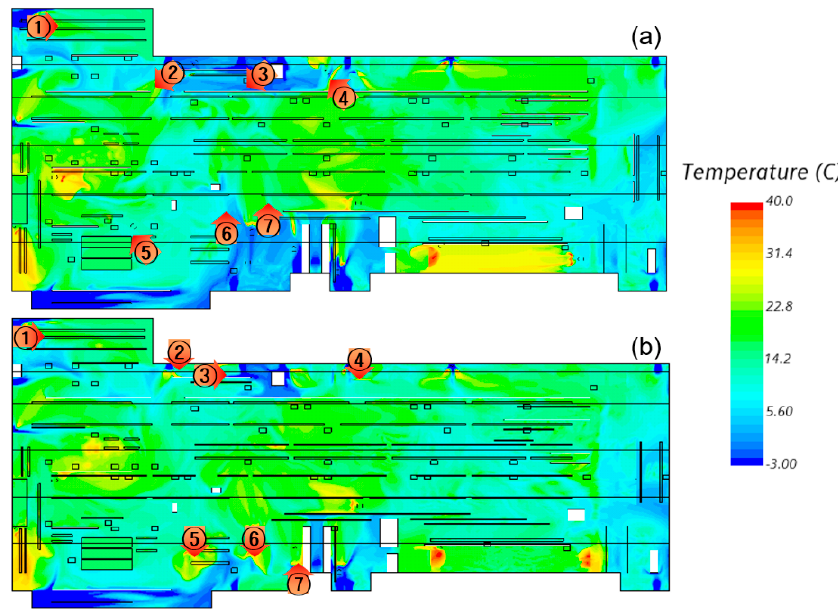
Figure 9. Heating performance of furnace location revision and blowing direction ( a ) standard condition; ( b ) revised condition (strategy 1).